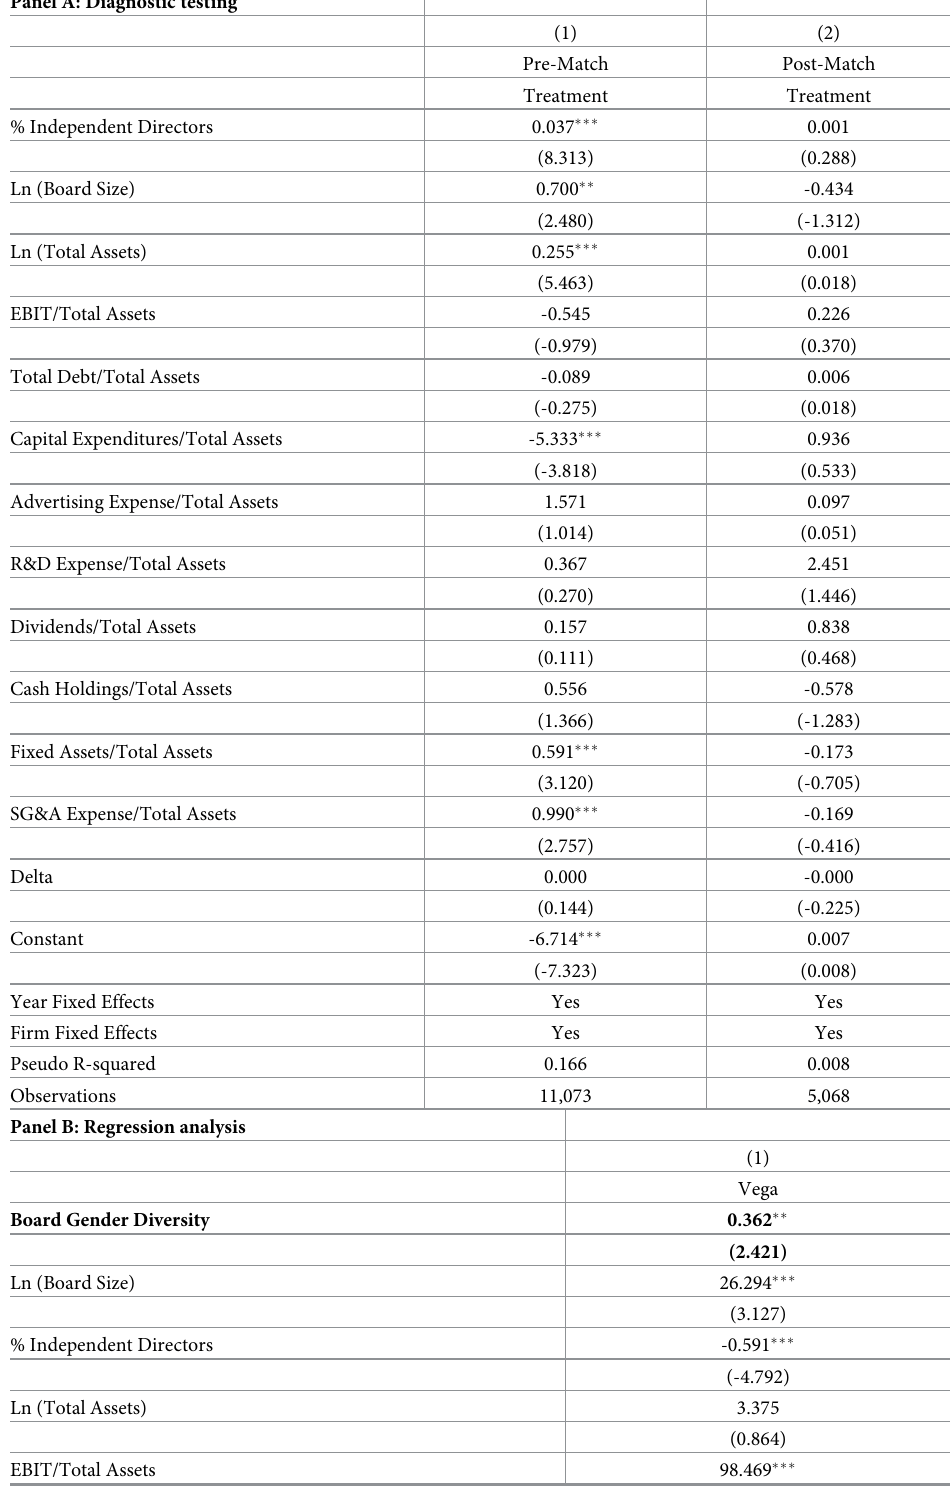
Table 3. Propensity Score Matching